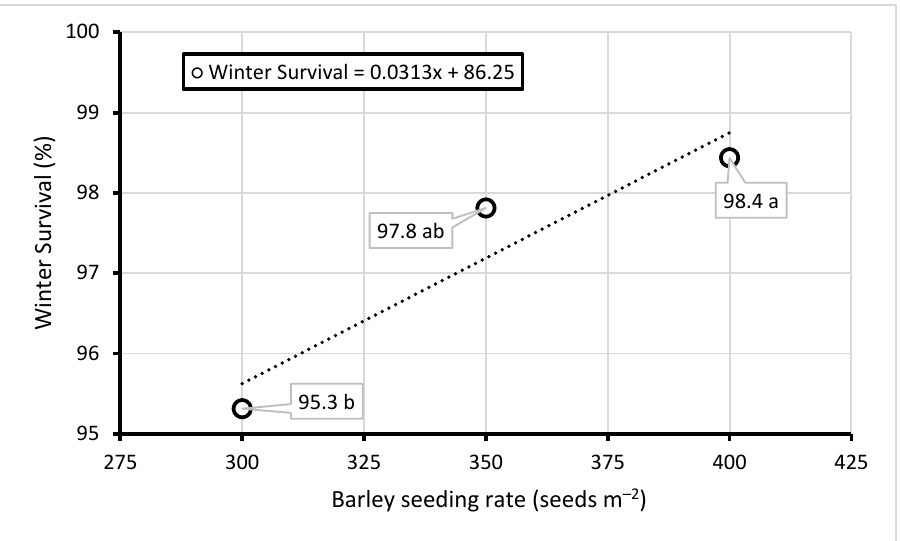
Figure 5. Mean winter survival (%) as a function of barley seeding rate. Means followed by the same letter are not significantly different from each other according to Bonferroni adjusted t-tests at p ≤ 0.05.